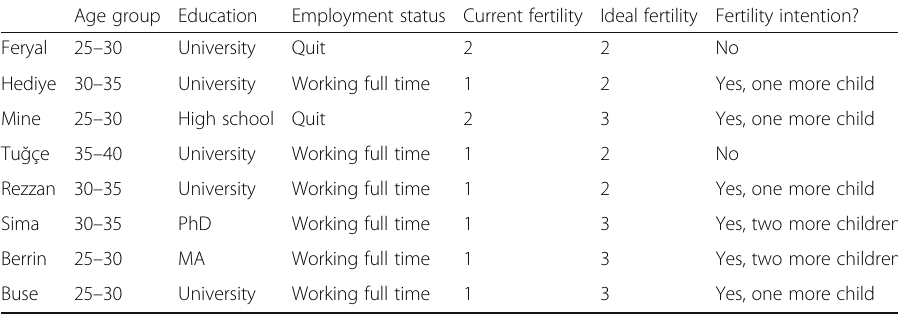
Table 3 Respondents ’ demographic characteristics, ideal fertility, and fertility intention Age group